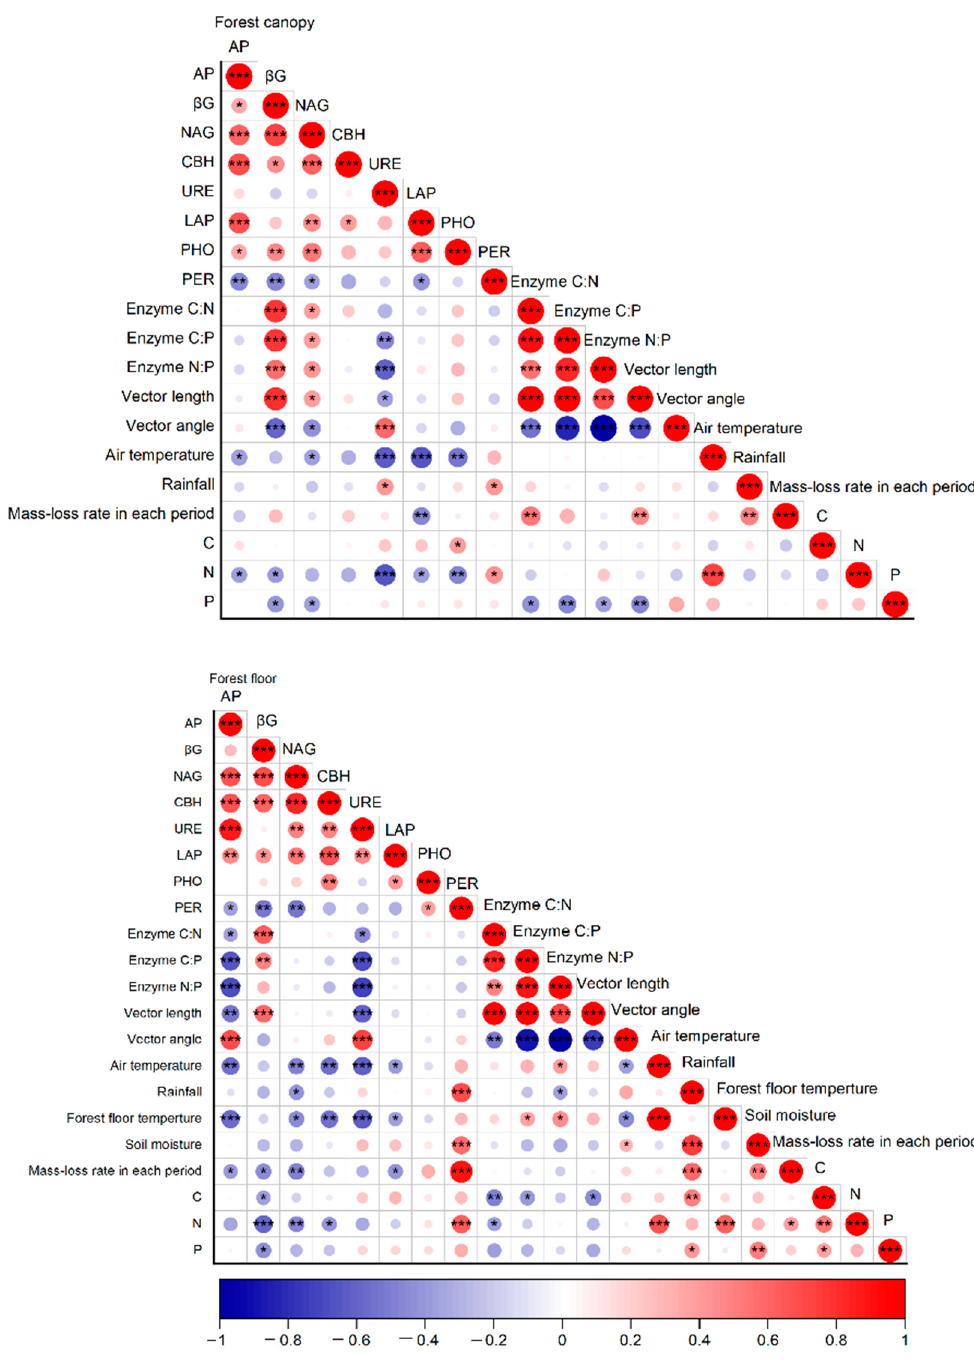
Figure 6. Correlation coefficients among enzyme activity, enzyme stoichiometry, enzyme vector features, environmental factors, and mass-loss rate during leaf litter decomposition in each period in the forest canopy and forest floor. ( p < 0.05 *, p < 0.01 **, p < 0.001 *** ) .